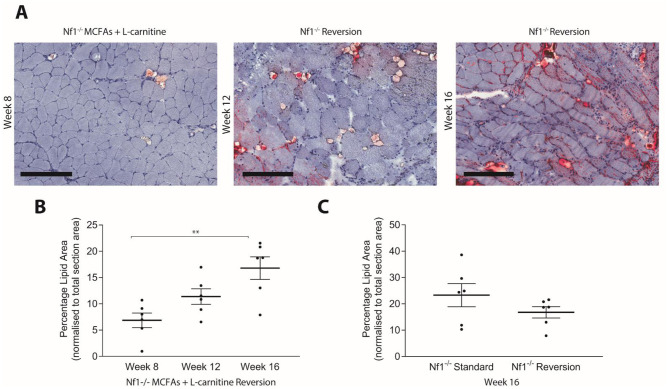
IMCL re-builds following reversion from MCFA + L-carnitine chow to standard chow.(A) Representative histopathology of quadriceps muscle from Nf1Prx1-/- mice following reversion to standard chow. (B) Cessation of MCFA + L-carnitine chow causes IMCL to return over 8 week period. (C) IMCL levels return to levels of standard chow fed Nf1Prx1-/- mice following 8 week of dietary reversion. Scale bar; 200um at 10x magnification, n = 6. Data presented as group mean ± SEM. p-values were assessed by one way ANOVA.